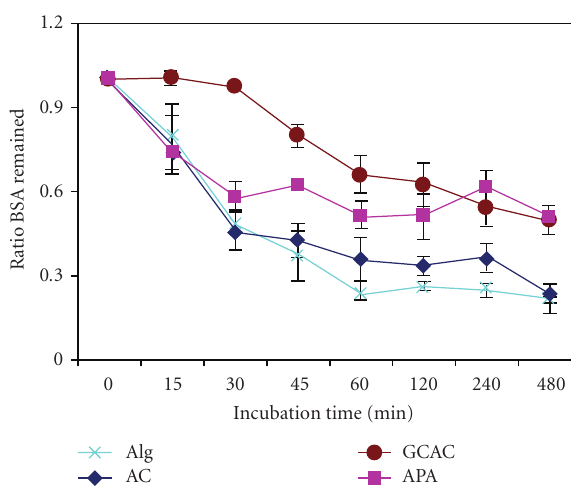
Figure 13: HPLC chromatographs of the encapsulated BSA in the GCAC and AC microcapsules as compared to BSA